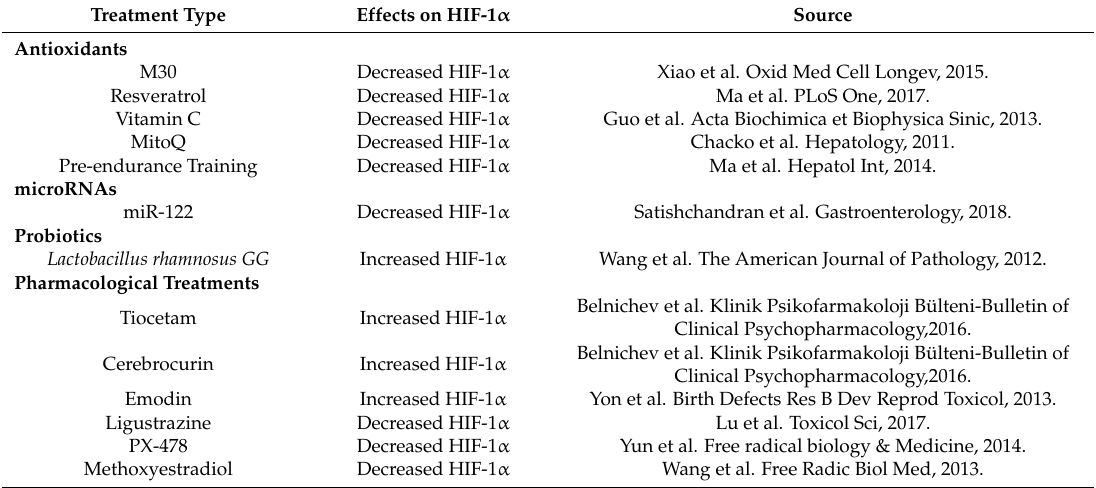
Table 1. Treatment options for alcohol-mediated tissue/organ